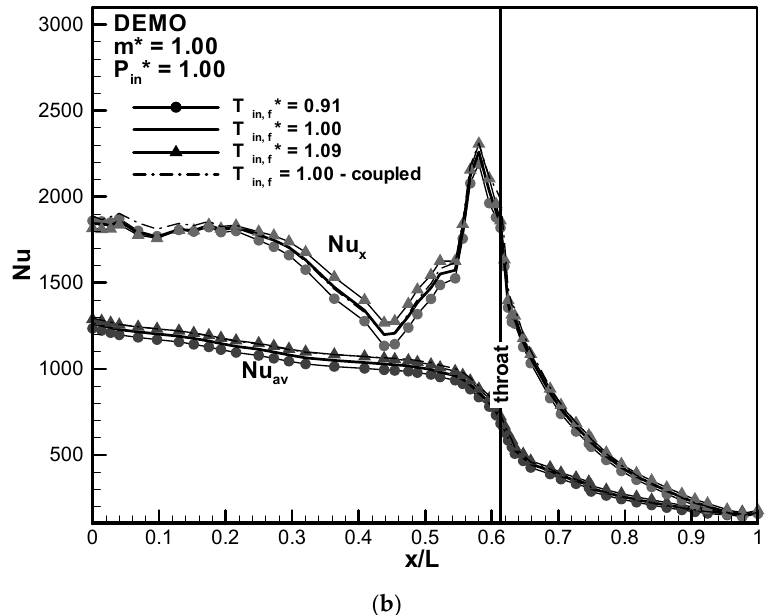
Figure 11. Axial profiles of local and average convective heat-transfer coefficients ( a ), local and average Nusselt number ( b ), considering different values of inlet fluid temperature (runs 1-4).